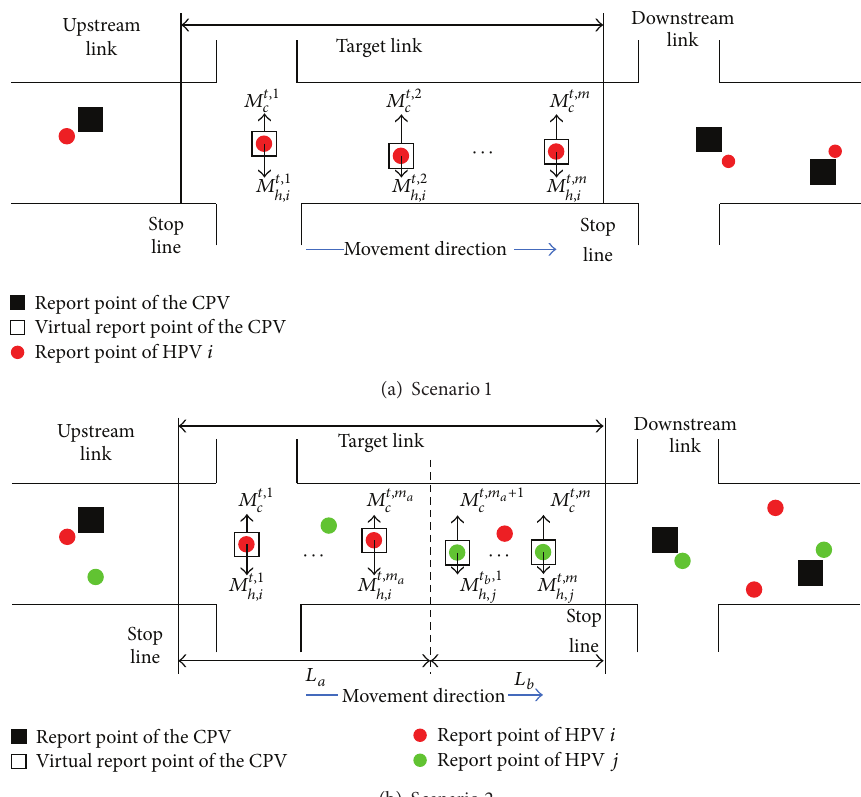
Figure 2: Creation of virtual report points in different